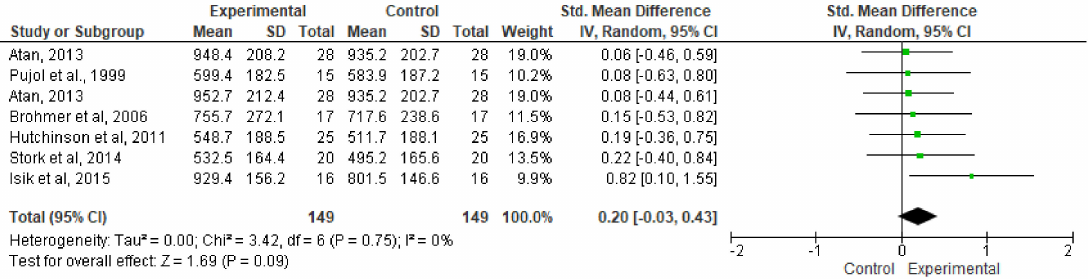
Figure 3. Forest plot comparing the e ff ects of music on absolute peak power performance.